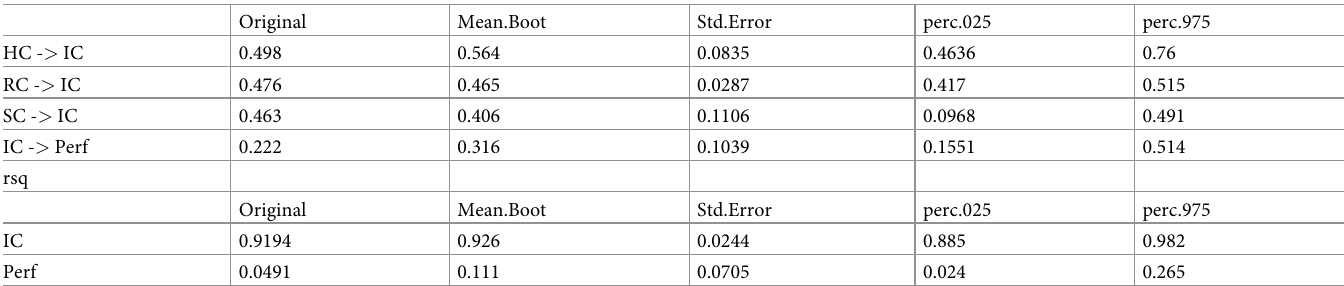
Table 3. Path of the intellectual capital components on added